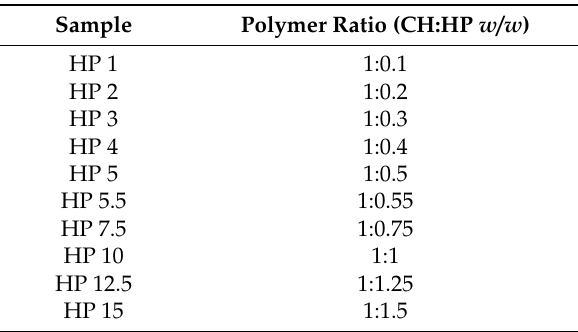
Table 1. Code and composition of the